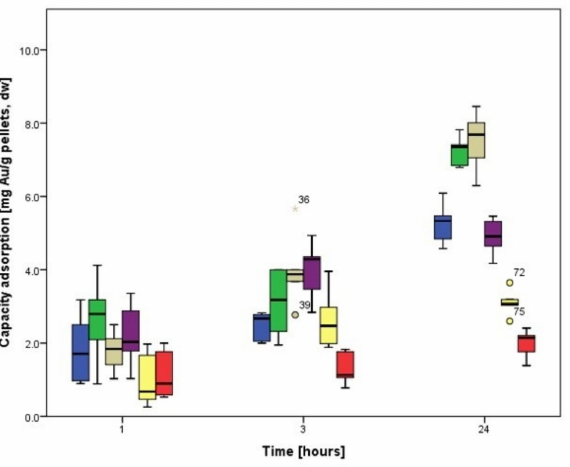
Figure 9. Au adsorbed on Cladosporium cladosporioides pellets at different pH values and contact times. pH: (cid:4) : 2; (cid:4) : 3; (cid:4) : 4; (cid:4) : 5; (cid:4) : 6; (cid:4) :